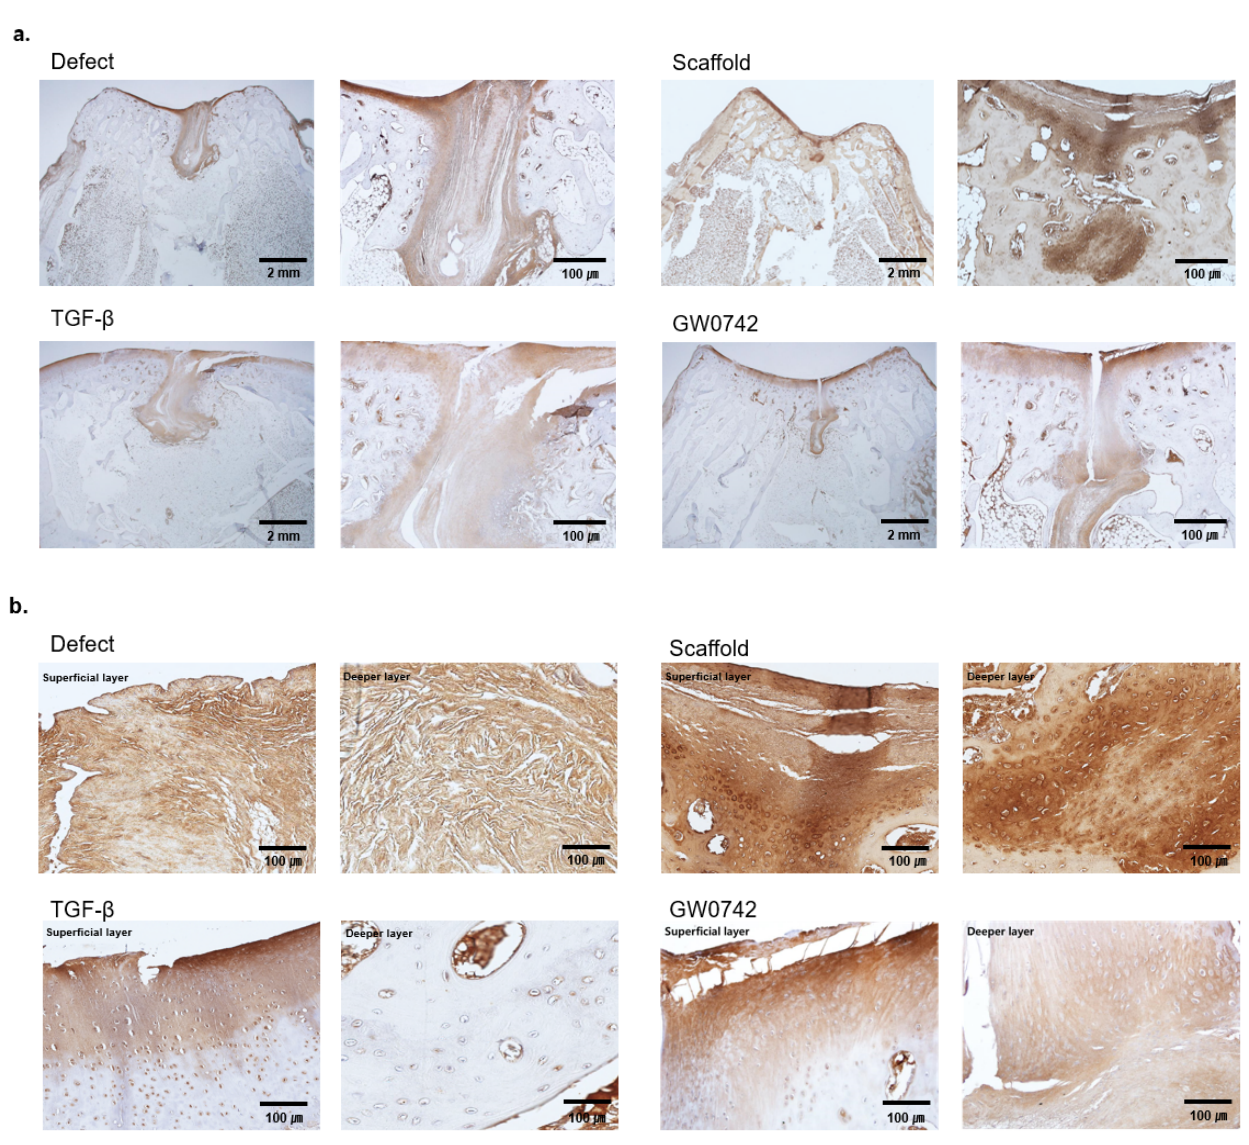
Figure 5. Immunohistology staining of collagen II. ( a ) Immunohistological observations of cartilage repair for a representative sample in each group after 12 weeks. Scale bar: 2 mm and 100 µm for each type II collagen staining. ( b ) Histological observations of each layer of the groups. The figure shows a representative sample in each group after 12 weeks. Scale bar: 100 µ m; type II collagen